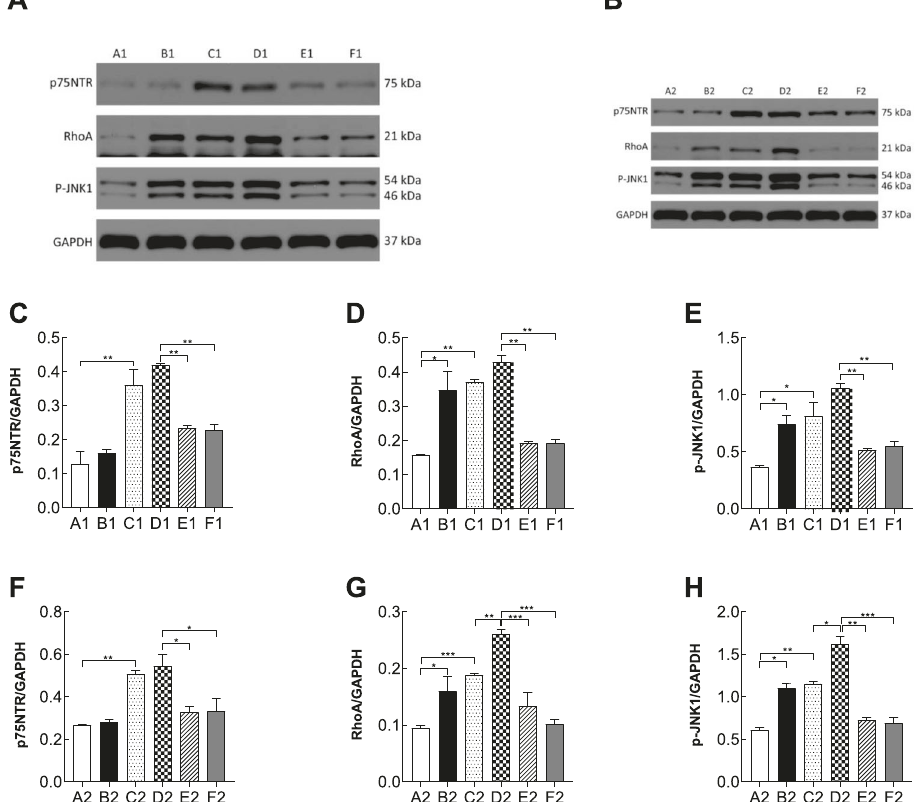
Fig. 6 Representative western blot analysis and quanti fi cation of densitometries of western blot band in all groups ( n = 3 per subgroup). ( A and B ) p75NTR, RhoA, and JNK1/GAPGH expression levels in neuronal cells were detected using western blotting. ( C – E ) Bar chart showing the ratio of p75NTR, RhoA, and JNK1 protein to GADPH in prefrontal cortical neurons. F – H Bar chart showing the ratio of p75NTR, RhoA, and JNK1 protein to GADPH in hippocampal neurons.Con control, OGD oxygen-glucose deprivation, CS corticosterone. A1: Con; B1: OGD; C1: